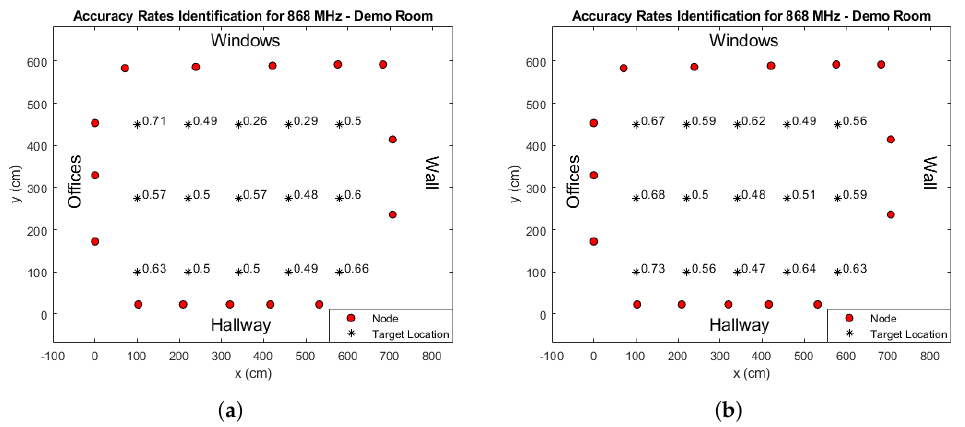
Figure 11. Identification accuracy rates for each location for both the ( a ) Euclidean distance minimization and ( b ) naive Bayesian classifier approach applied to 868 MHz RSS data.